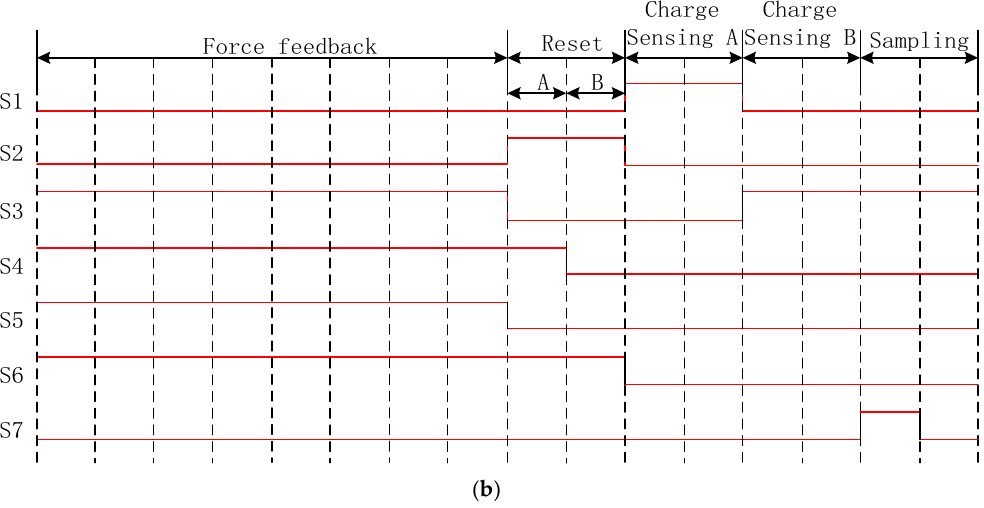
Figure 3. Front-end charge sensing circuit and timing diagram. ( a ) Front-end charge sensing circuit for micro-accelerometers; ( b ) Timing diagram for front-end charge sensing circuit.